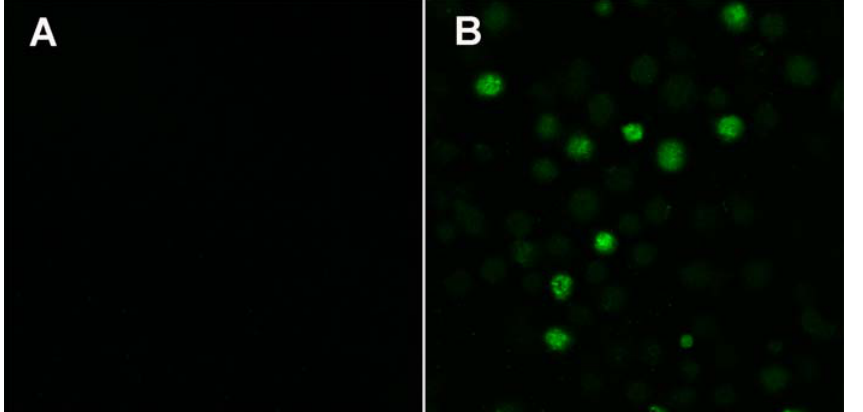
Figure 1. Uptake of FITC-labeled TP5 by EBV-transformed B cells. Confocal images were taken in living cells in the absence (A) and presence (B) of FITC-labeled TP5. The scale bar corresponds to 20 m m.